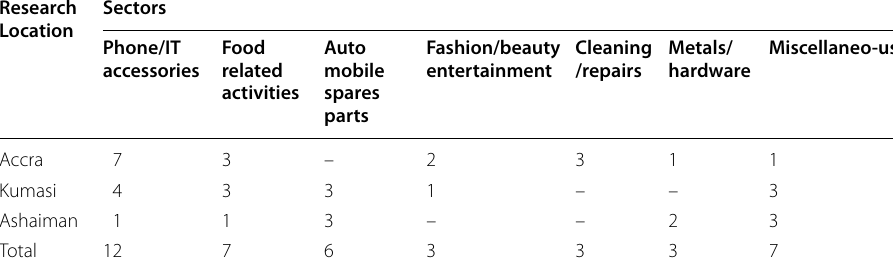
Table 1 Location and sectorial distribution of businesses Research Sectors Location Phone/IT Food accessories